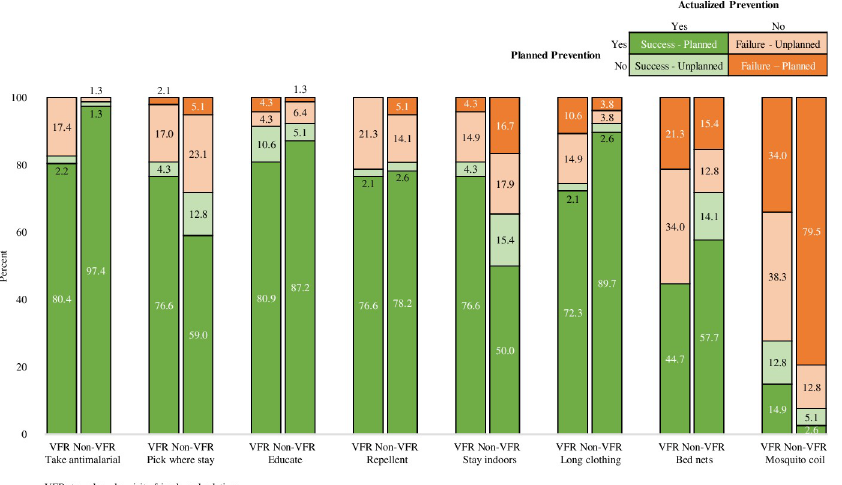
Fig 3. A cross-sectional, multi-setting survey of malaria prevention knowledge, attitudes, and practices among US travelers to sub-Saharan Africa: Planned and actual malaria prevention outcome matrix among travelers visiting friends and relatives (VFRs) and non-VFRs surveyed at the travel clinic both before and after travel.